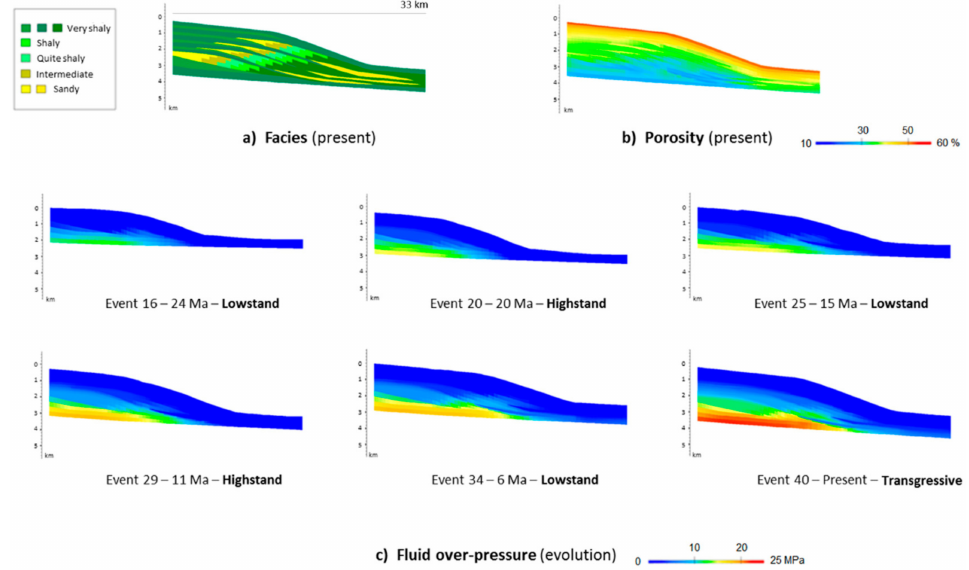
Figure 3. Porosity and overpressure simulated on the base case scenario. ( a ) reminder of the lithological facies distribution; ( b ) present-day porosity; ( c ) overview of the fluid overpressure evolution from six geological events; vertical exaggeration ×